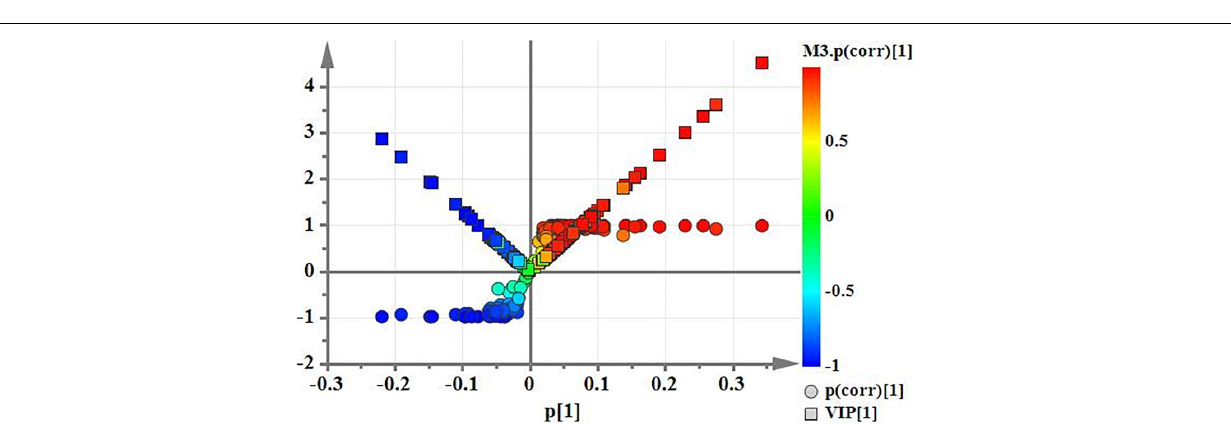
FIGURE 7 | PCA differentiation using the GC-MS whole metabolome analyzed data of the individually cultured MTB in the absence (C) and presence (J) of 8.0 µ g/ml DHA-CS NPs.